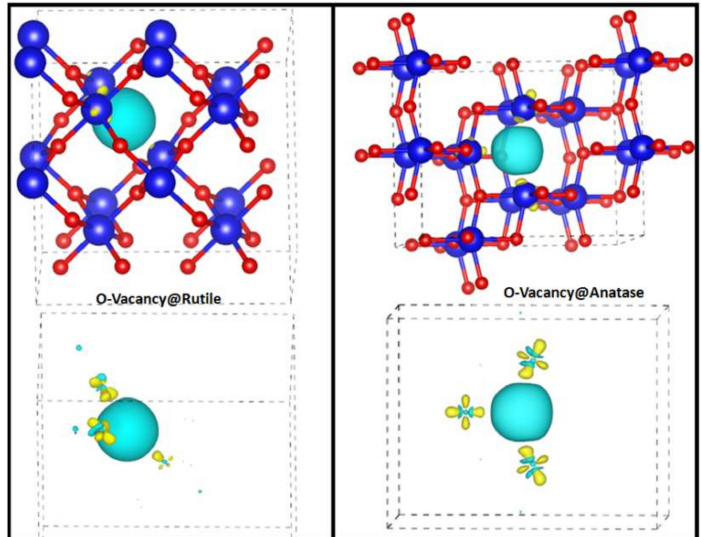
Figure 2. The di ff erence between charge densities of the single O-vacancy and pure bulk structures of rutile and anatase. The blue and yellow lobes represent the negative and positive levels of isosurfaces, respectively. The net charge transfers have also been represented. Red and blue spheres represent O and Ti atoms,